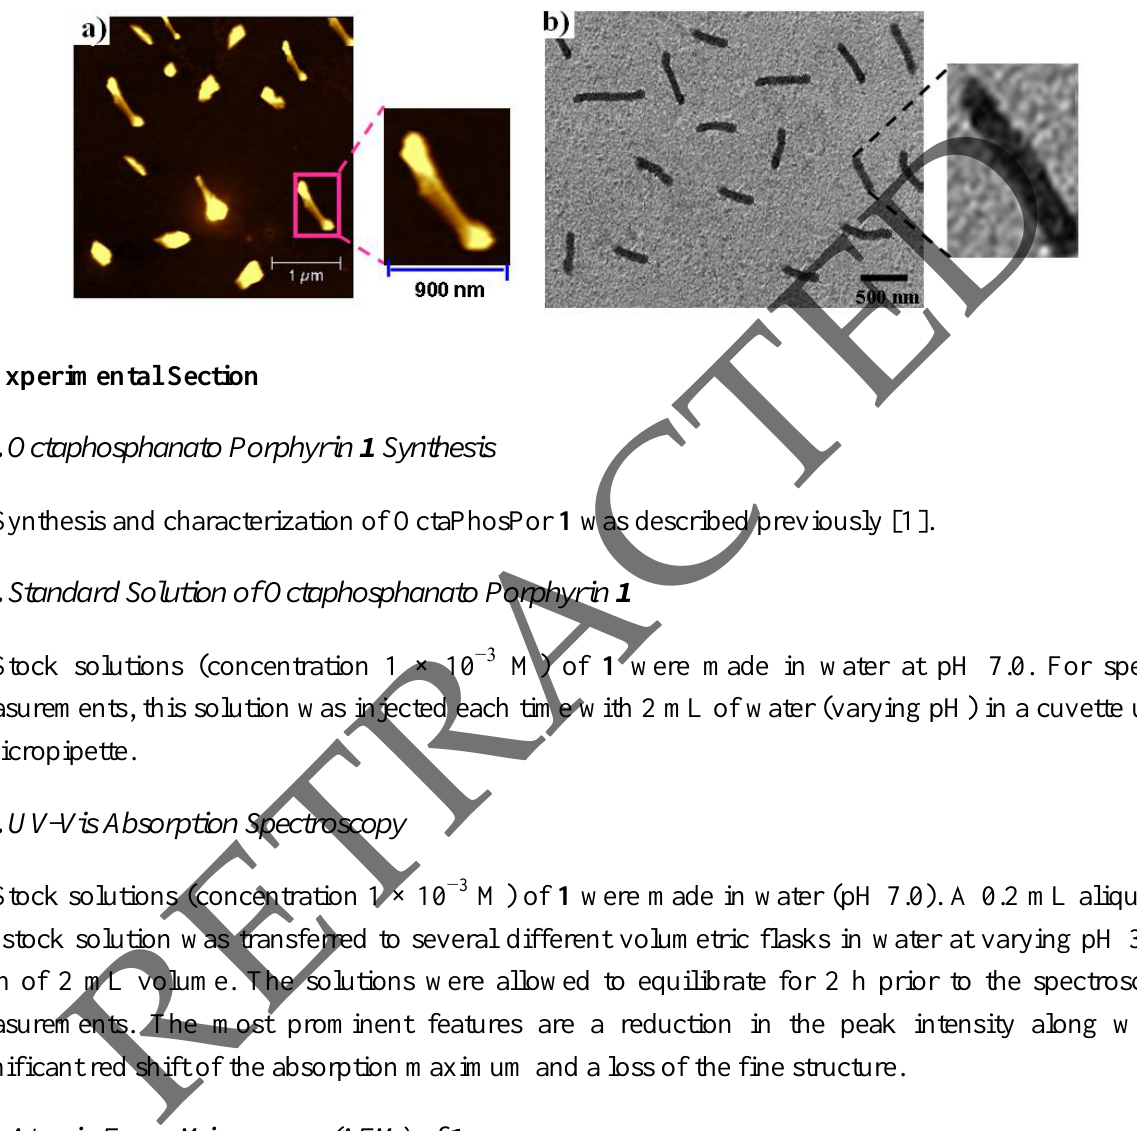
Figure 5. ( a ) Atomic force microscopy (AFM) height images of 1 (10 −4 M) upon spin-cast on silicon wafer plate after the solvent has evaporated; Inset = high magnification of AFM image ( b ) Transmission electron microscopy (TEM) micrograph of 1 on holey, carbon-coated copper grids (scale bar = 500 nm), shows nanorods in water at pH